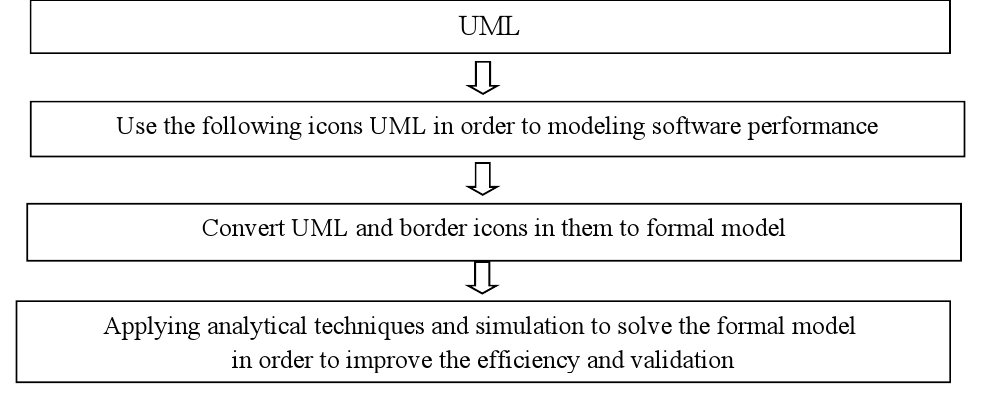
Fig. 1. Proposed idea in